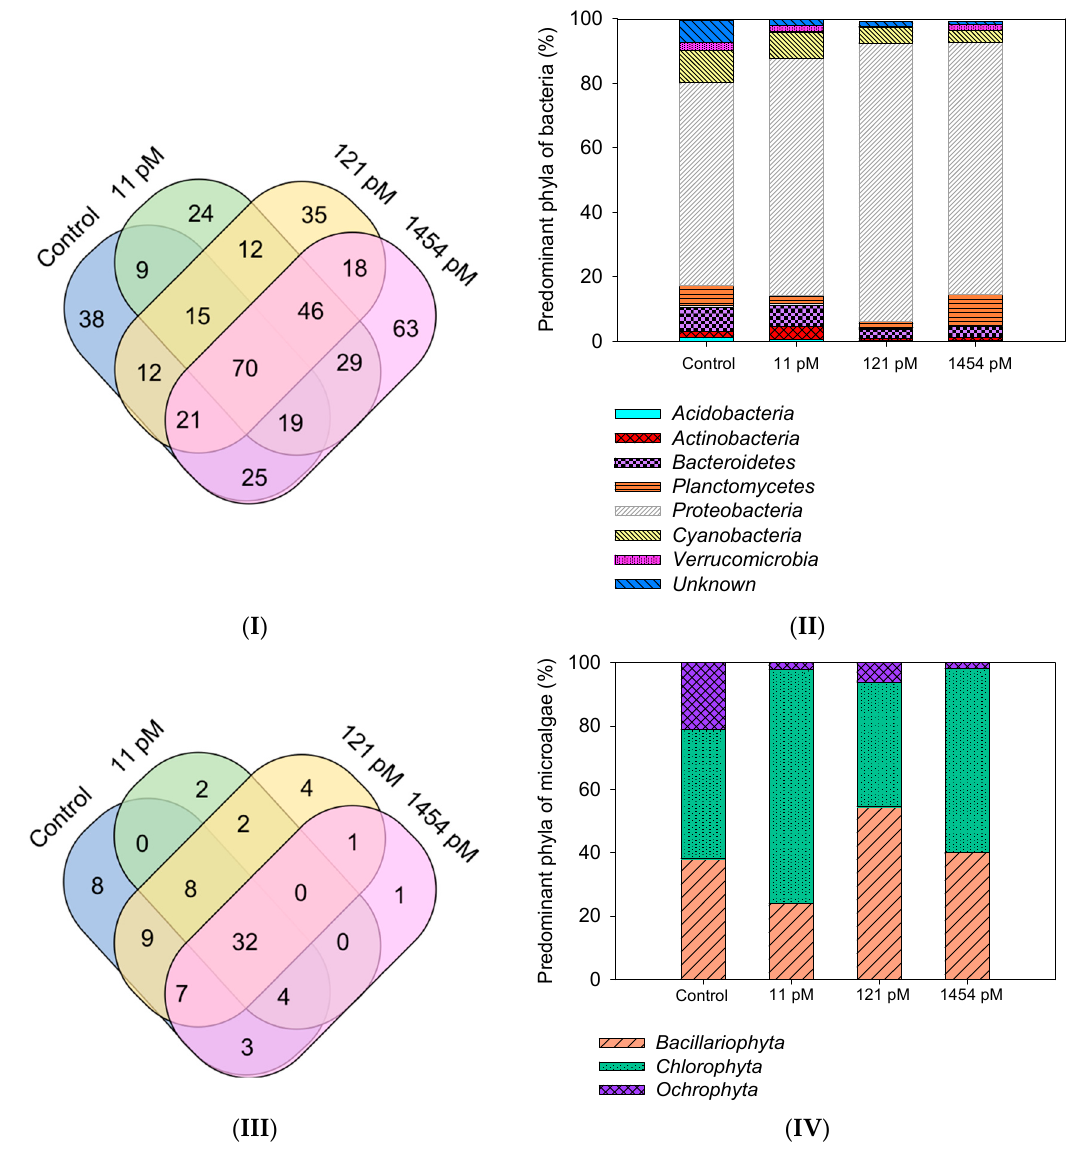
Figure 3. Venn diagram showing the shared and specific OTUs between control biofilm and biofilms grown in 11 ± 2 pM, 121 ± 9 pM, and 1454 ± 54 pM Hg and their composition at the phylum level; ( I ) and ( II ) bacteria, respectively, and ( III ) and ( IV ) microalgae, respectively.